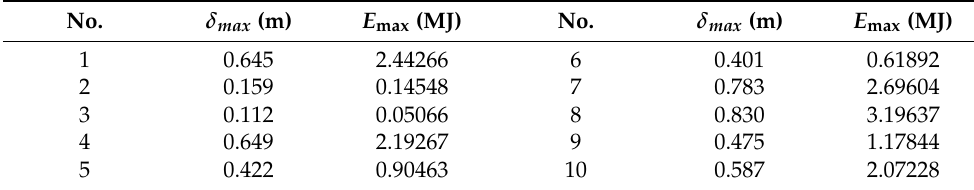
Table 7. Prediction results of DPSO-BP-ANN model for training samples.